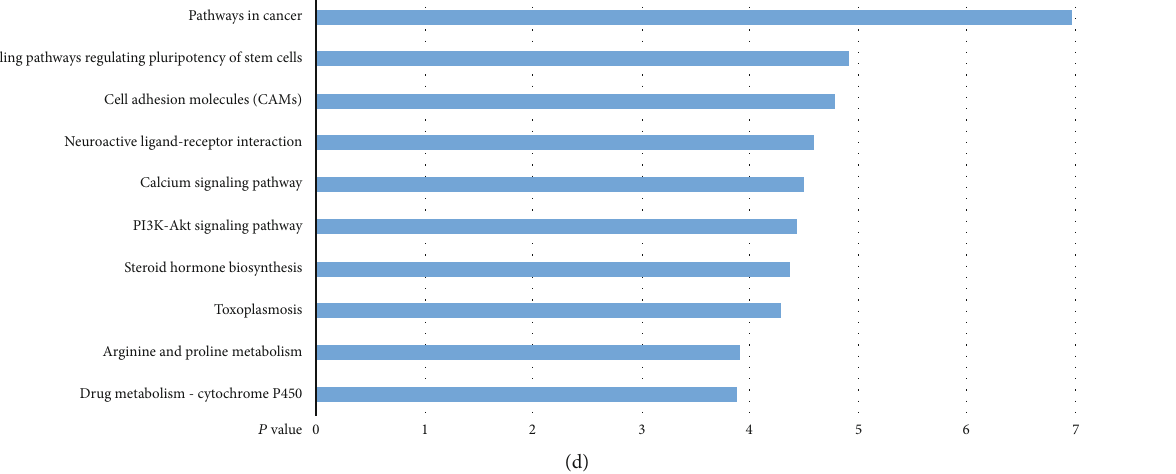
Figure 2: Top 10 signi fi cant enrichment GO and KEGG terms of DEGs in GSE29111: (a) BP: biological process; (b) CC: cellular component; (c) MF: molecular function; (d) KEGG: signaling pathway. The vertical axis represents the GO or KEGG pathway terms; the horizontal axis shows the negative log10 ( P